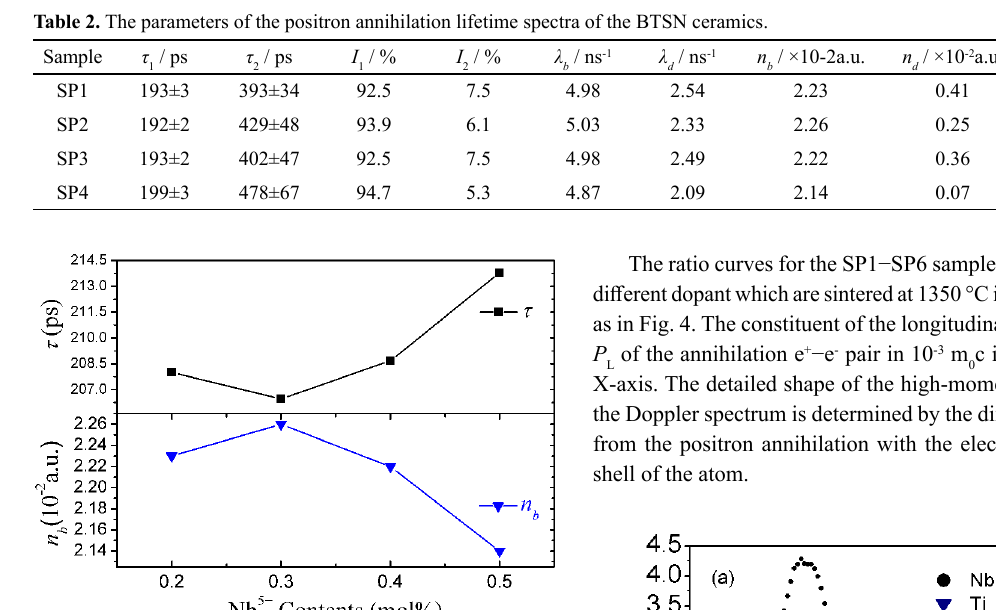
shell of the atom.